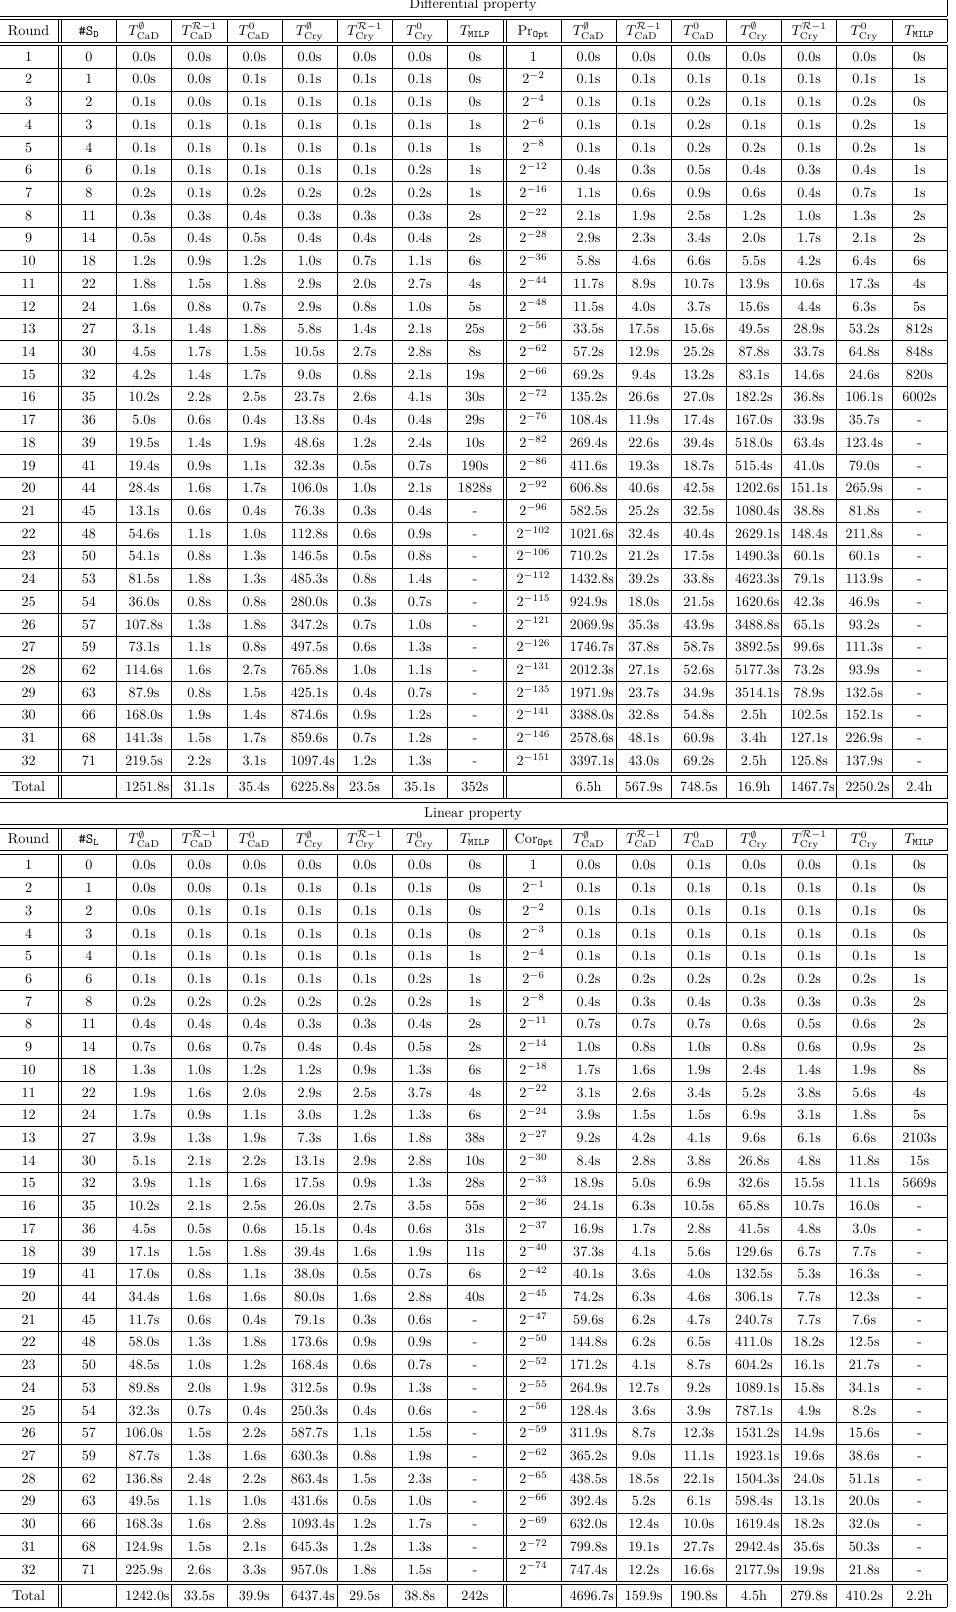
Table 15: Experimental results of LBlock